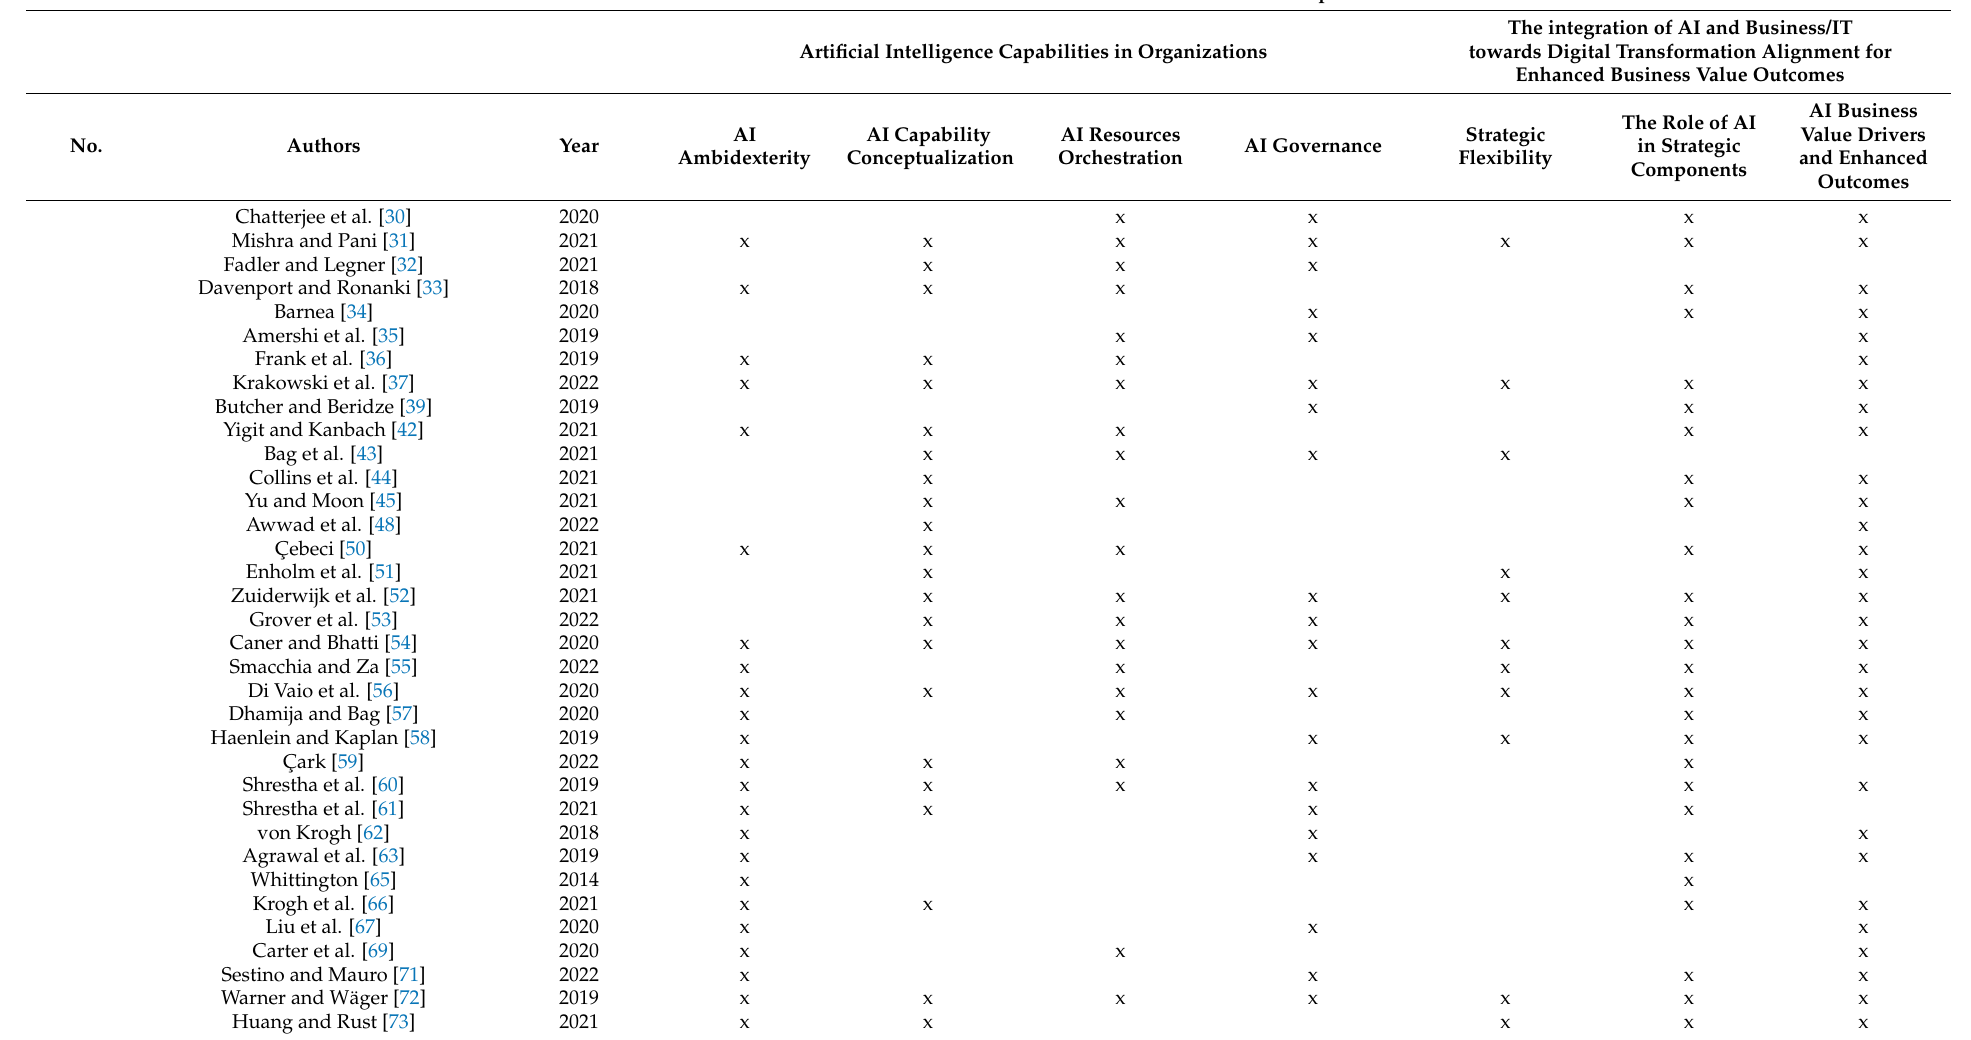
Table A2. Concept matrix table. Source: Own